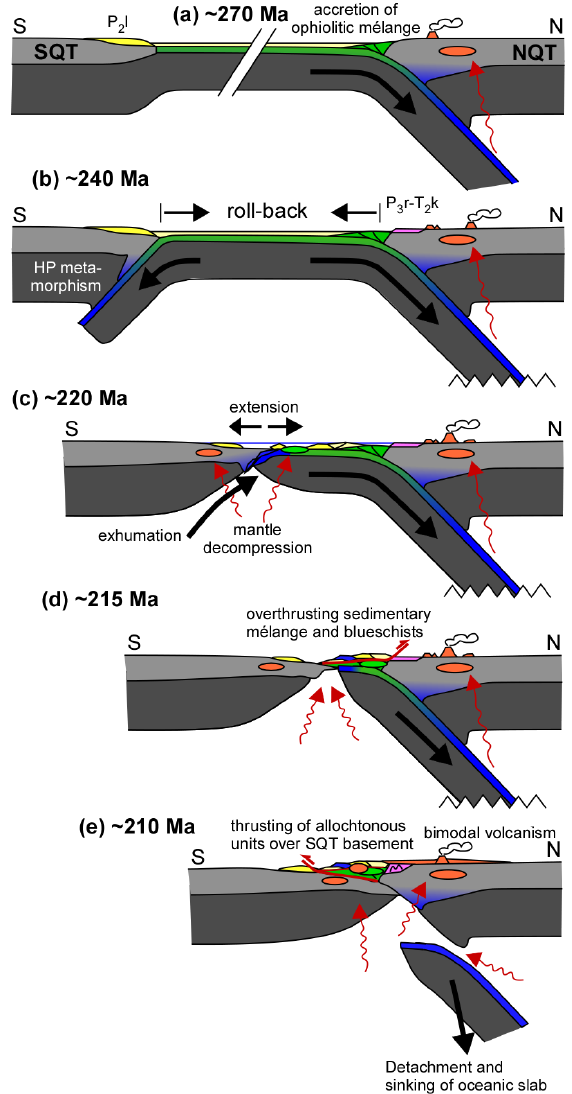
Figure 7. Schematic drawings of the Permian to Early Jurassic geological evolution of the Shuanghu–Tethys. Ages shown in the drawings are approximate only. (a) Northward subduction of the Shuanghu–Tethys underneath the NQT started at about 275Ma. (b) Minor southward subduction would have commenced in the Early Triassic, necessitating rollback and convergence of the NQT and SQT. (c) Interaction between the converging subduction zones led to extraction of the short southern slab and concomitant ex- humation of high-pressure rocks. These are brought in contact with surface-derived margin sediments and basement in a strongly ex- tensional setting. (d) With ongoing convergence of the NQT and SQT, the sedimentary mélange (with high-pressure rocks) is thrust on top of the ophiolitic mélange at the LSS suture. (e) Ophiolitic and sedimentary mélange are ultimately thrust onto the SQT upon final collision of the two terranes. Asthenospheric upwelling leads to bimodal igneous activity on both sides of the Shuanghu–Tethys suture